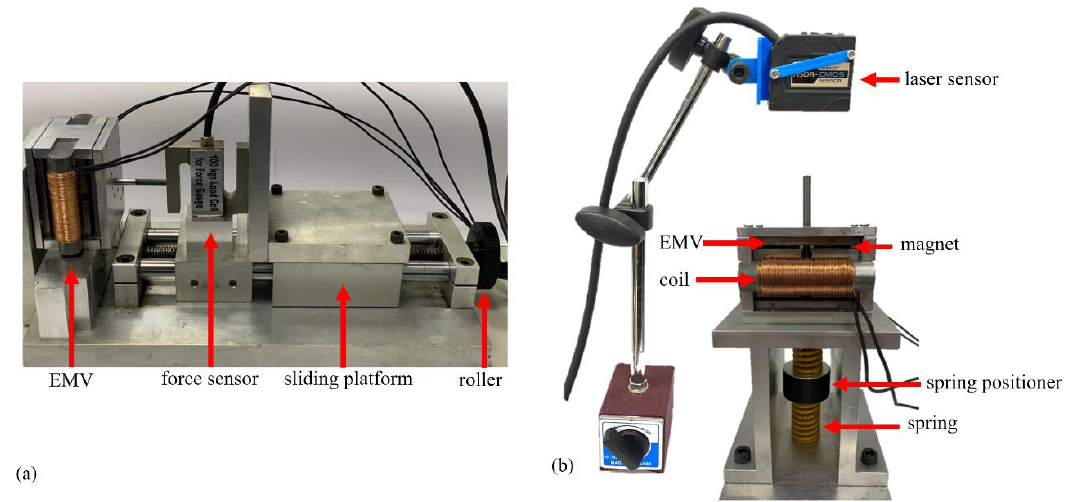
Figure 9. Test setup for ( a ) maximum attraction force and ( b ) EM valve operation.